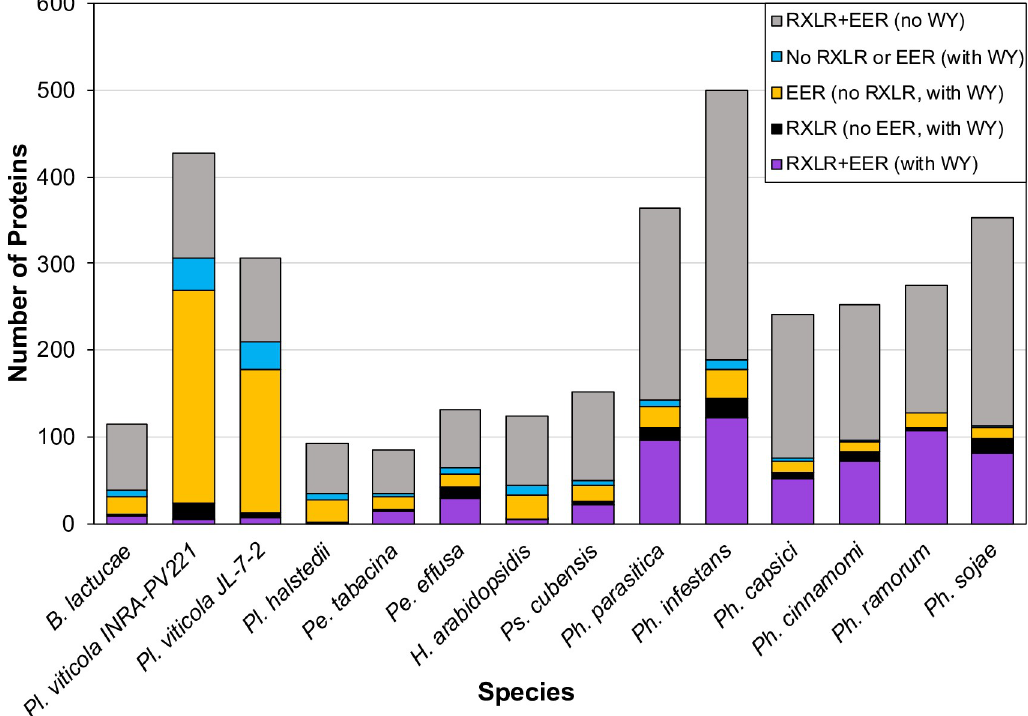
Fig 2. Distribution of predicted secreted WY effectors with or without RXLR and/or EER motifs in the genomes of downy mildew pathogens and Phytophthora species. HMMer was used to search predicted secretomes for each species for the WY domain. For the WY domaining containing proteins, the presence of RXLR and EER were determined by searching for [RQGH] XLR within the first 60 amino acids after the signal peptide and [DE][DE][KR] within the first 100 amino acids after the signal peptide. For the non-WY domain containing proteins, the RXLR and EER was determined by searching for a strict “RXLR” with [DE][DE][KR], within the first 60 and 100 amino acids, respectively, plus proteins found by searching for the RXLR-EER domain using the RXLR-EER HMM from